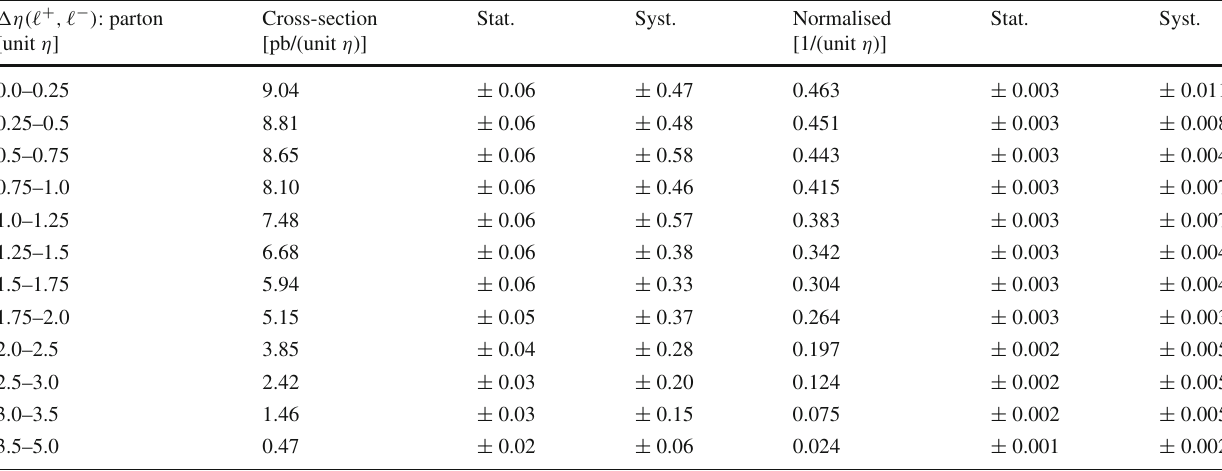
Table3 Summaryoftheparton-levelabsoluteandnormaliseddifferentialcross-sectionsasafunctionof (cid:3)η((cid:13) + ,(cid:13) − ) ,withstatisticalandsystematic uncertainties in each